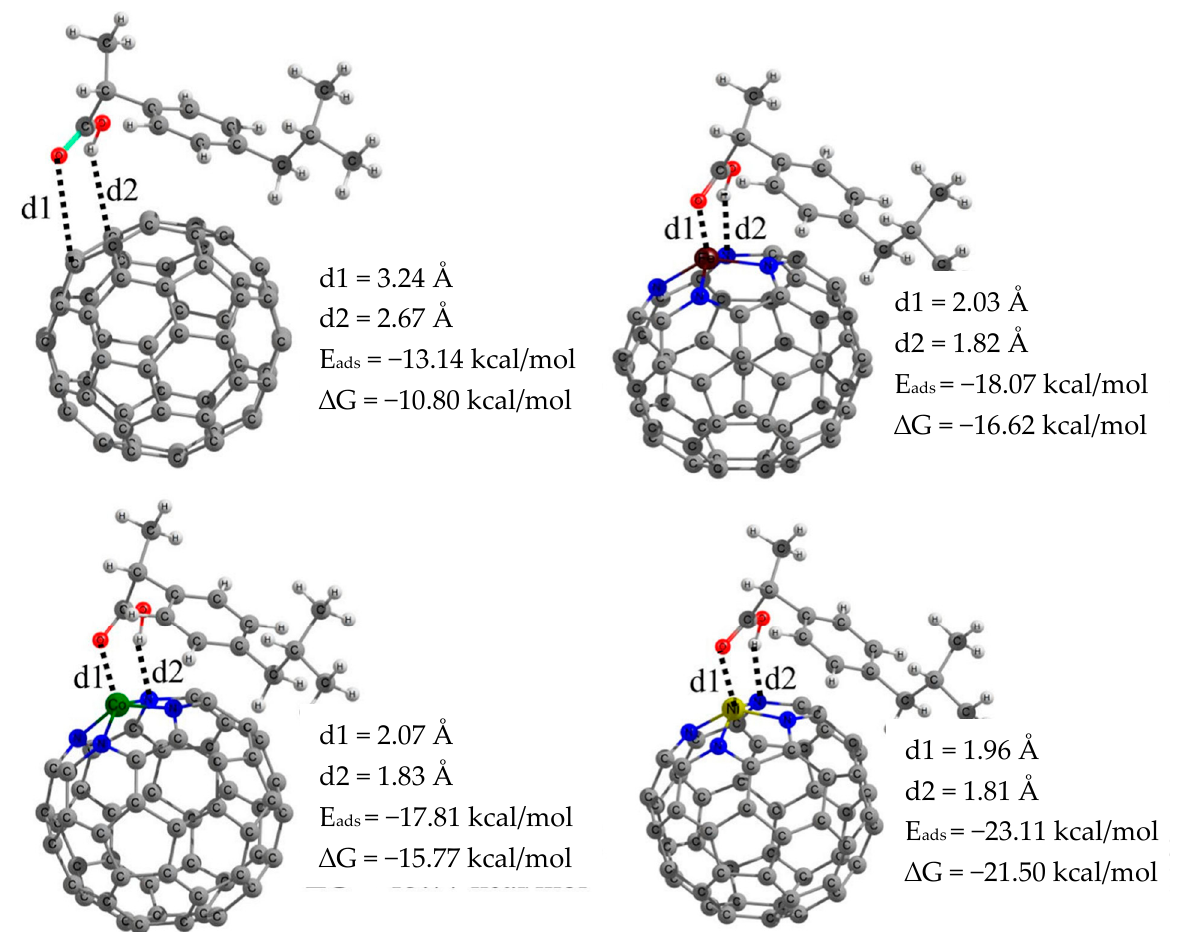
Figure 5. Molecular configurations of the adsorbed Ibp on the surface of doped fullerenes [40].